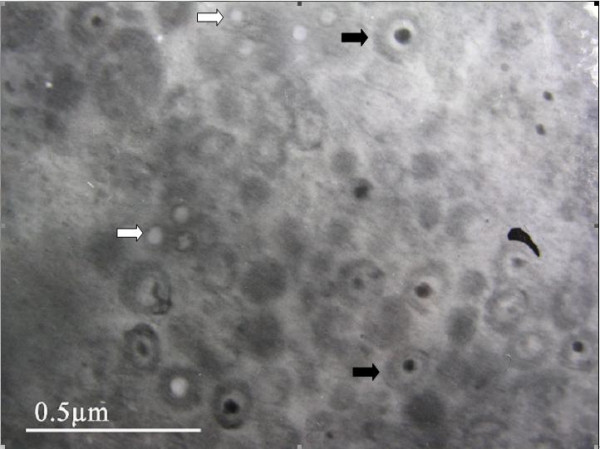
Electron microscope analysis of Vero cells infected PRV SA215/VP2. Two types of virus particles were observed in the same Vero cell. Recombinant PRV particles are indicated by the black arrow. Empty virus-like particles probably formed from PPV VP2 protein are indicated by the white arrow.